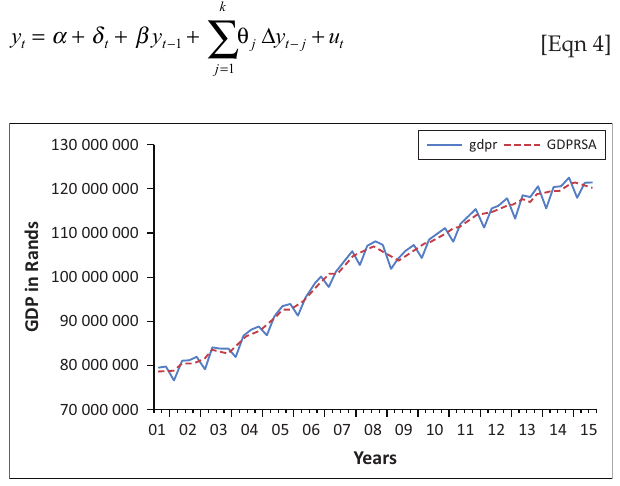
FIGURE 1: Provincial and seasonal adjusted gross domestic product (R billion, constant 2010 prices).